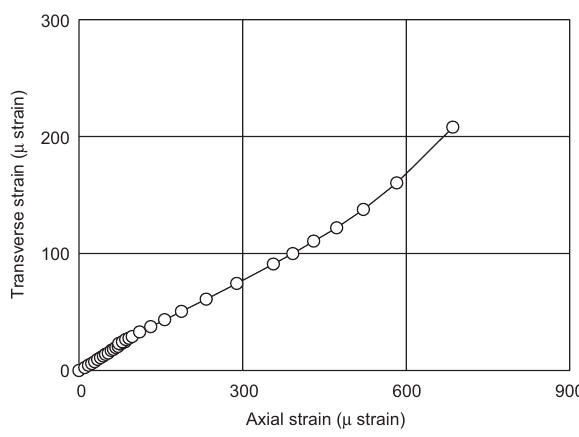
Figure 11 Variation of the transverse strain vs. the axial one.